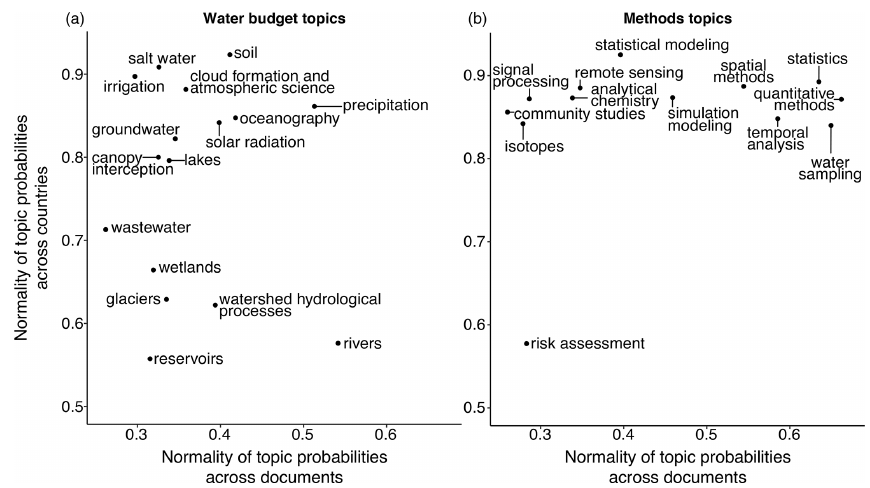
Figure 8. Normality of research topics for (a) water budget topics and (b) methods topics.